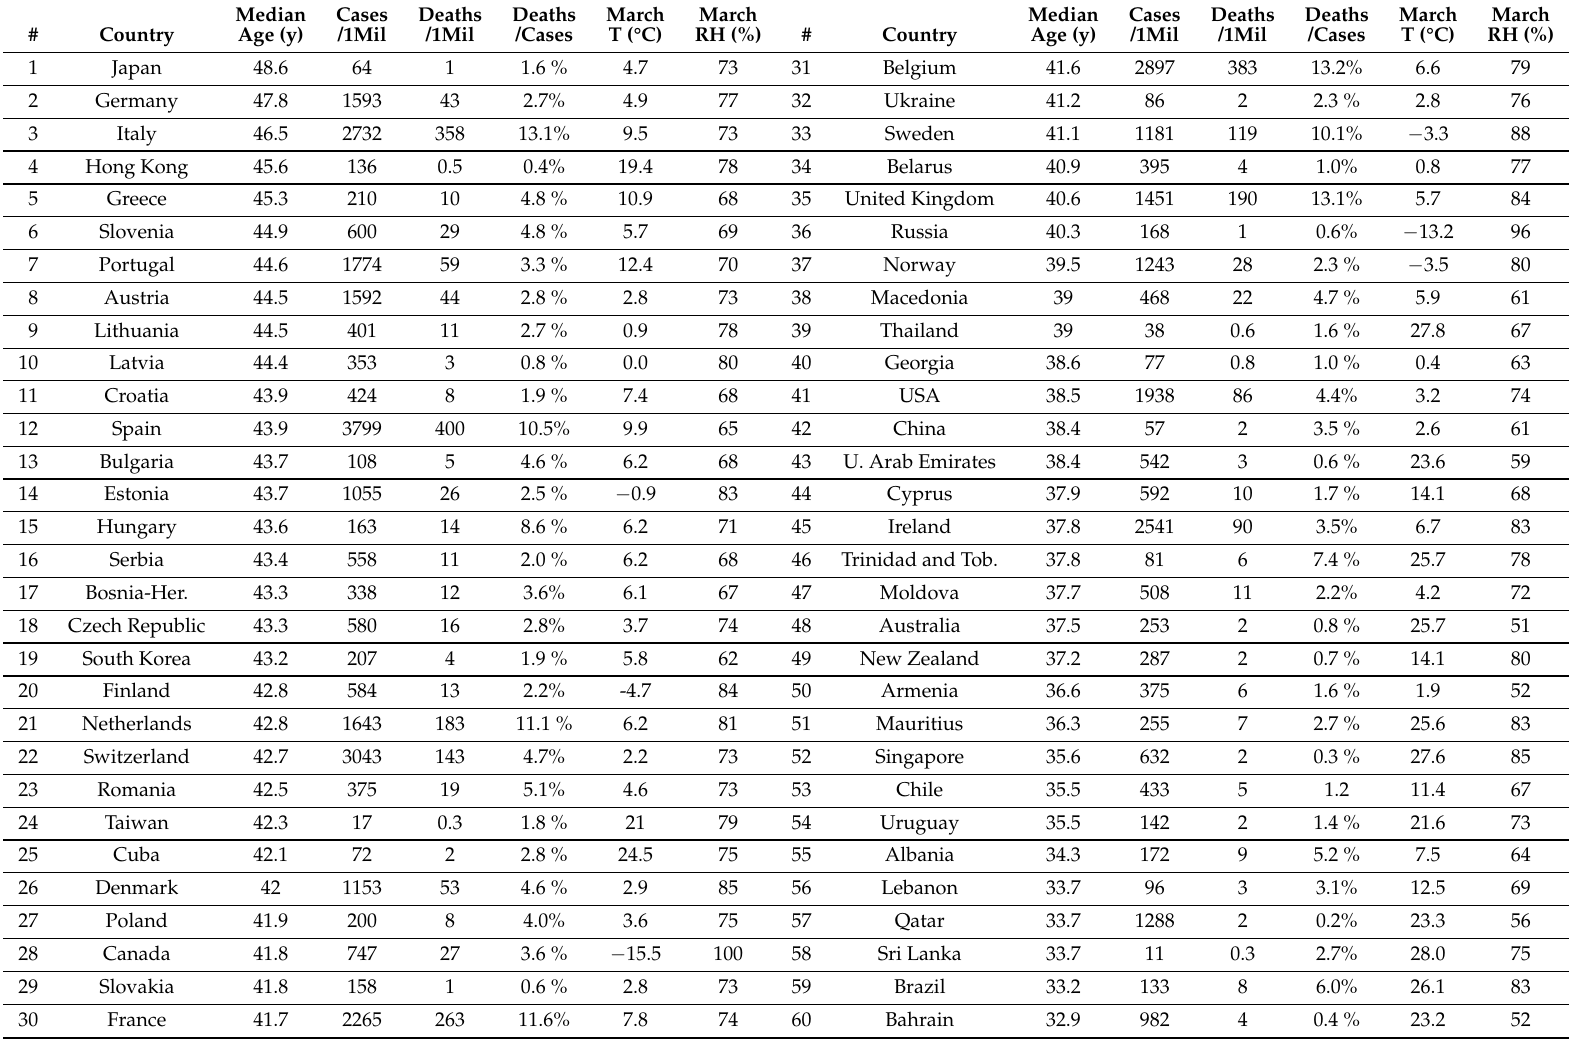
Table 7. Sample of the COVID-19 data ranked by the country mean population age. The complete table is found in the Supplementary